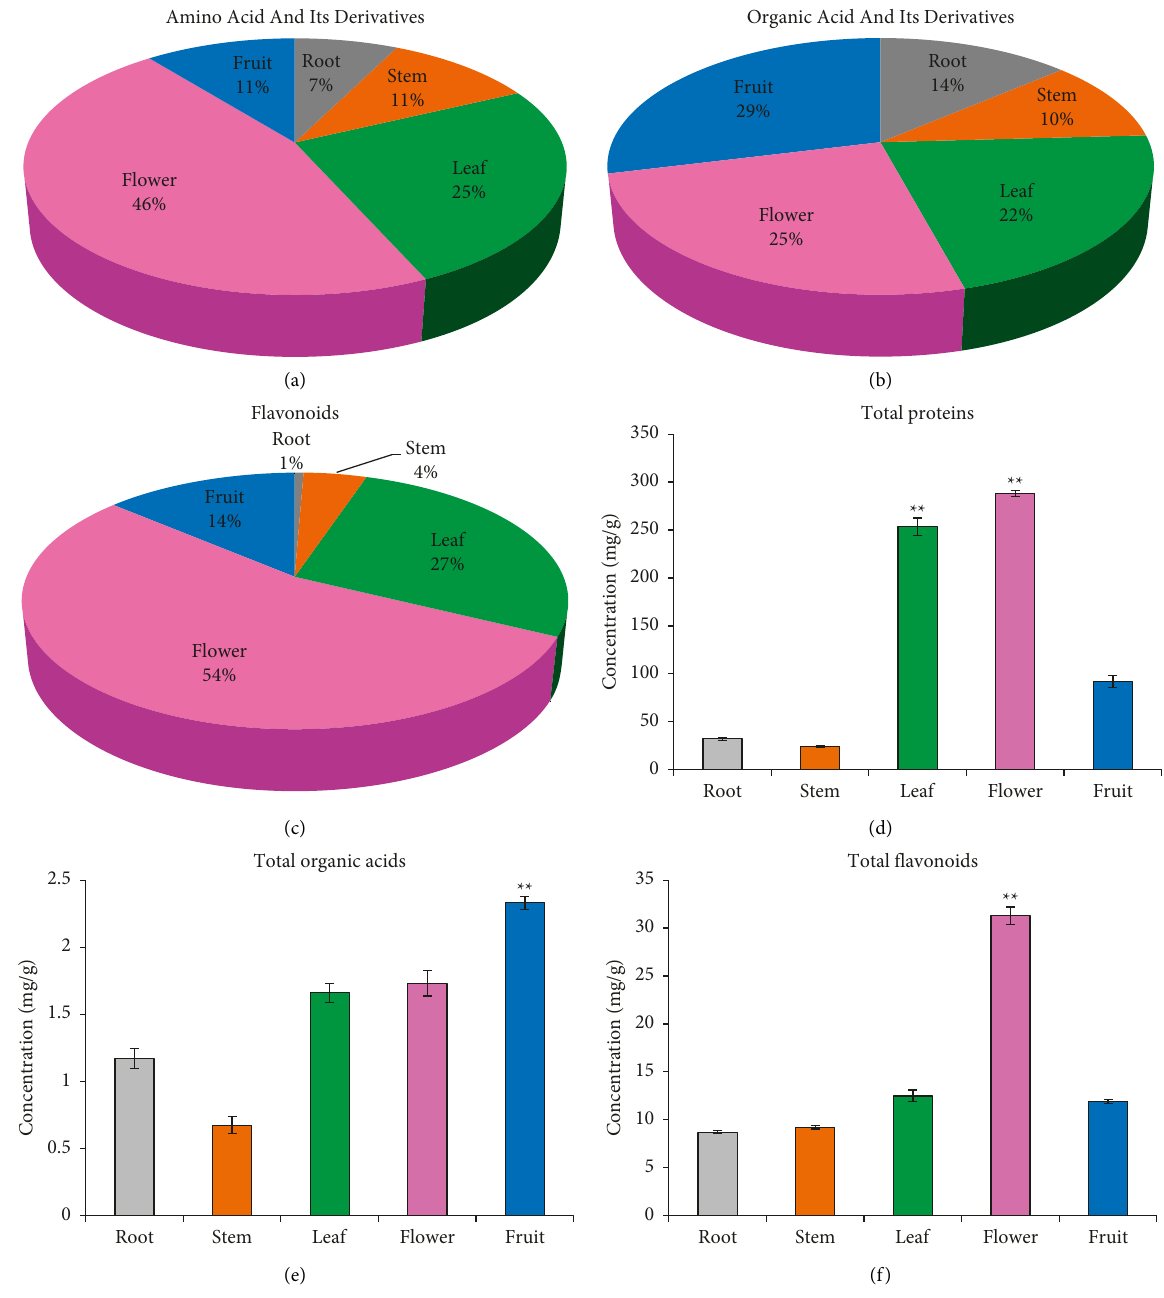
Figure 9: Comparison of the detected results by HPLC-MS/MS and common determination method in D . nobile . (a) Amino acid and its derivatives ( n � 123), (b) organic acid and its derivatives ( n � 105), (c) flavonoids ( n � 111), (d) total proteins, (e) total organic acids, (f) total flavonoids. (a), (b), and (c) were based on the results of HPLC-MS/MS. (d), (e), and (f) were detected by corresponded colorimetry or